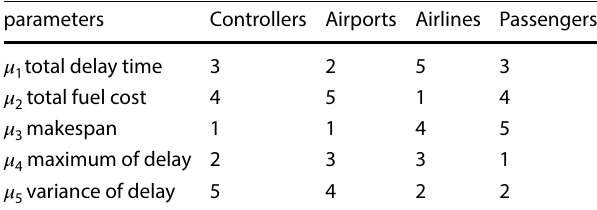
Table 6 Investigation results of different stakeholders parameters